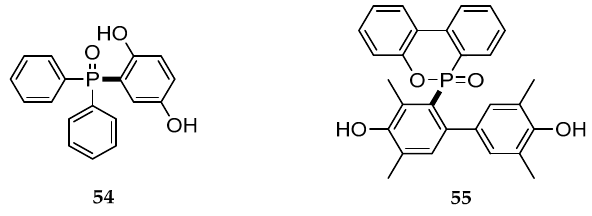
Figure 25. Chemical structures of compounds 54 and 55 .